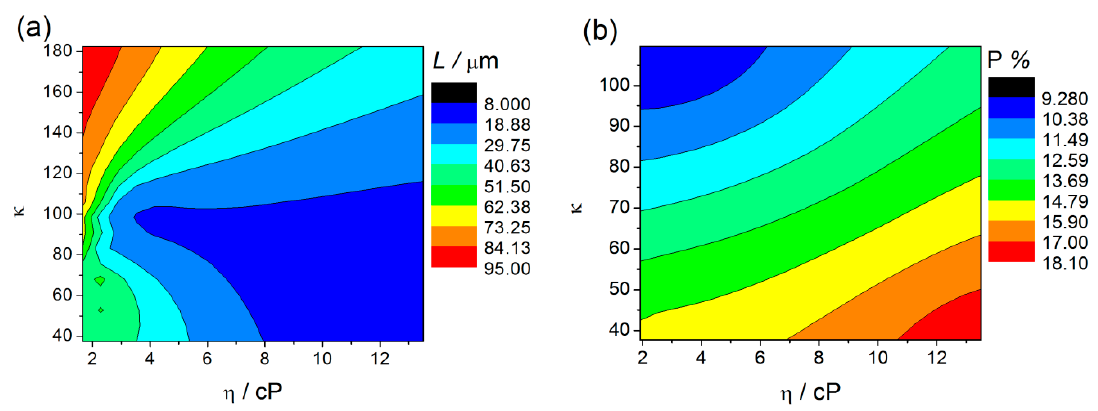
Figure 11. Counterplots of L ( a ) and P ( b ) as a function of the solvent parameters η and κ , obtained by interpolation (cubic Spline-20 points) of η , κ , L and P values.